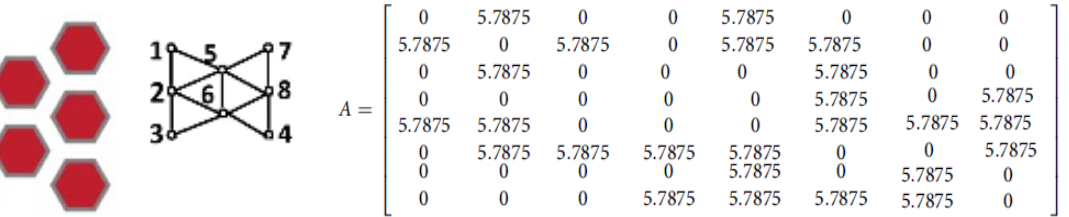
Figure 12. Example of a 2D case of a graph with 8 grains, i.e., 8 vertices and 13 edges, with the corresponding weight matrix, containing overall capacitance change [42].